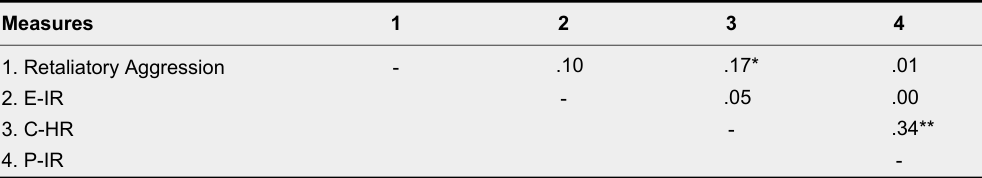
Pearson r Correlation Indices Between Readiness for Aggression and Retaliatory Aggression 4321Measures